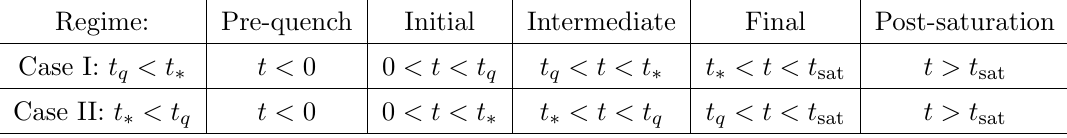
Table 1 . Time regimes for the evolution of entanglement entropy following a (cid:12)nite